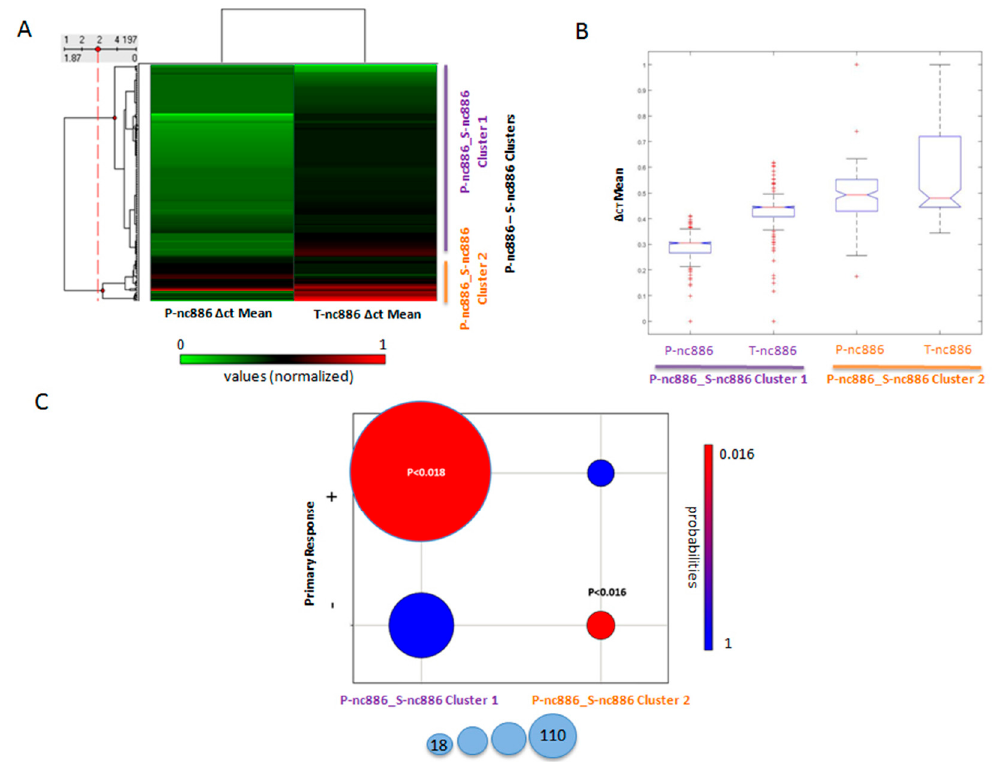
Figure 2. Association of the expression level of protein kinase R (PKR) and nc886 determined by the ∆ ct mean values identified by RT qPCR in tumour (T), plasma (P), and healthy (S) tissues with the objective response to first-line chemotherapy. ( A ) P-T_nc886 clusters: Biclusters of subjects sharing ∆ ct mean values of nc886 in P and T. ∆ ct mean values are normalized between 0 (green) and 1 (red). ( B ) Boxplot of ∆ ct mean values of nc886 in P and T for each cluster. ( C ) Correlation between the objective first-line chemotherapy response and the nc886 ∆ ct mean clusters (Figure 2A). p -values were calculated with hypergeometric statistics. Colour code for p -values’ statistical significance is indicated from high (red) to low (blue). The size of the circles indicates the number of individuals in the relationship.